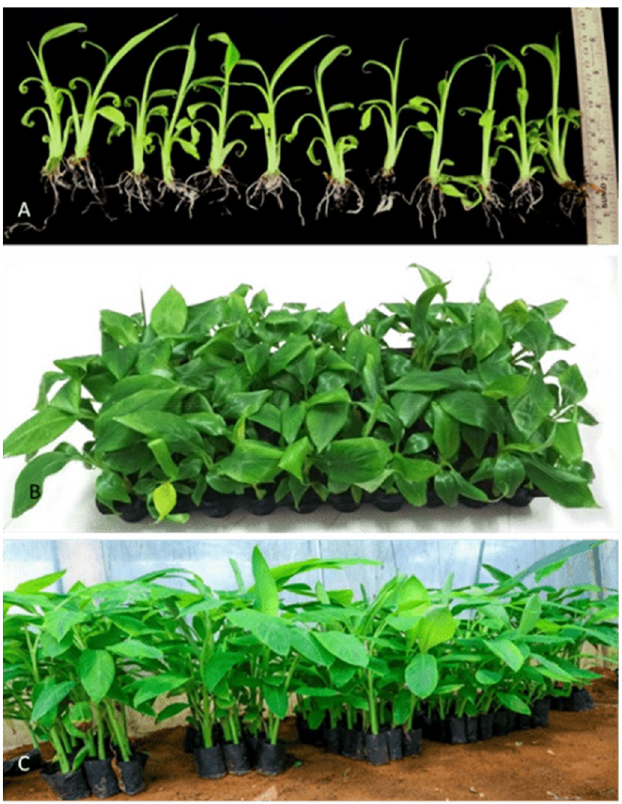
Figure 4. Hardening of plantlets. ( a ) Plantlets produced from bioreactor, ( b ) primary hardened plants, ( c ) SECONDARY hardened plants (Images arranged in Adobe Photoshop